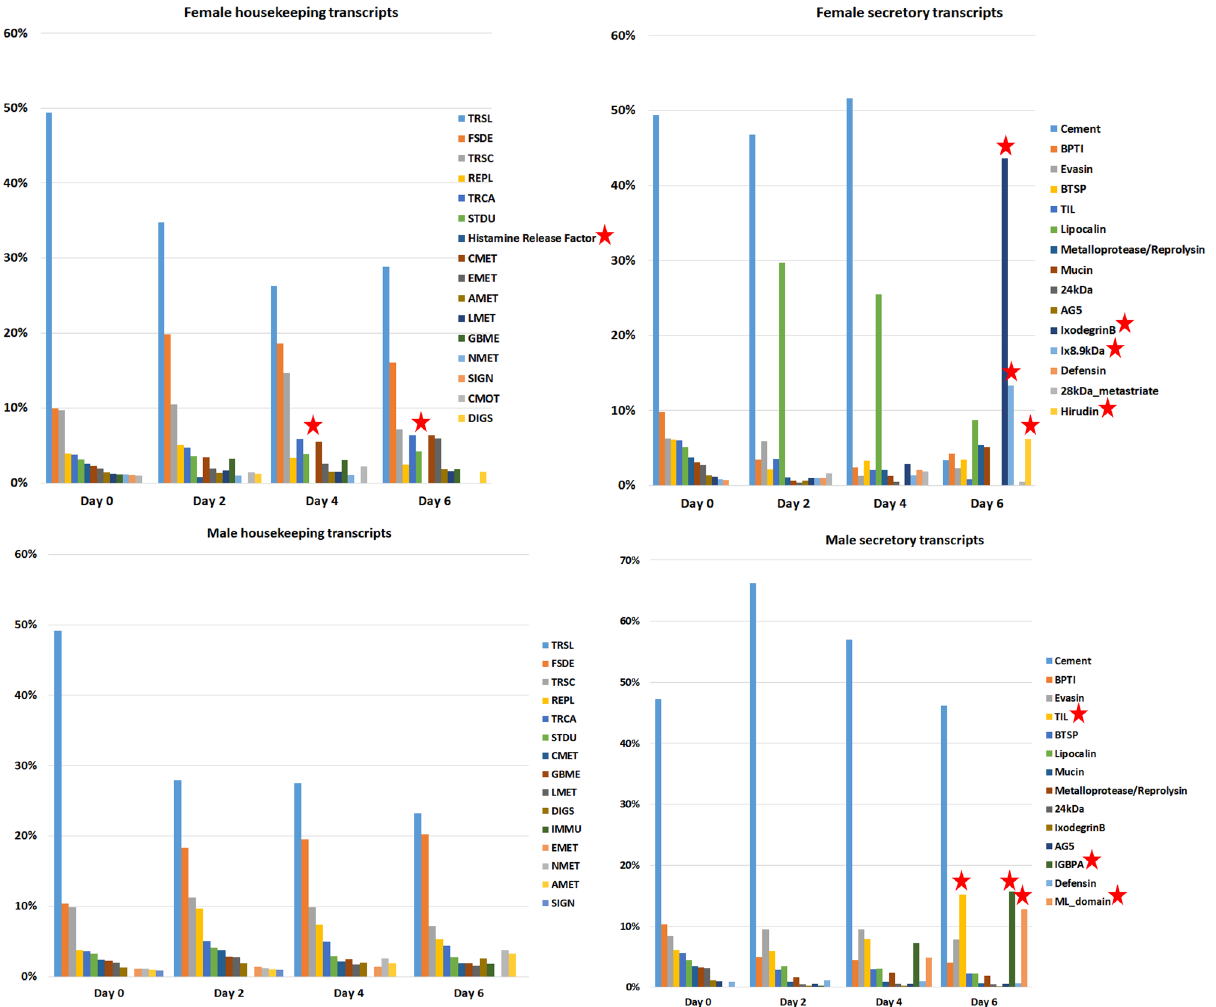
Figure 5. Female and male housekeeping and secretory protein expression patterns per day expressed as percentage per day based on TPM ≥ 0.5 cut off for females and males. Protein families with a significant increase or decrease in expression are indicated with stars. Represented housekeeping proteins were: translation (TRSL), folding sorting and degradation (FSDE), transcription (TRSC), replication and repair (REPL), transport and catabolism (TRCA), signal transduction (STDU), carbohydrate metabolism (CMET), energy metabolism (EMET), amino acid metabolism (AMET), lipid metabolism (LMET), glycan biosynthesis and metabolism (GBME), nucleotide metabolism (NMET), signaling molecules and interaction (SIGN), cell motility (CMOT), digestive system